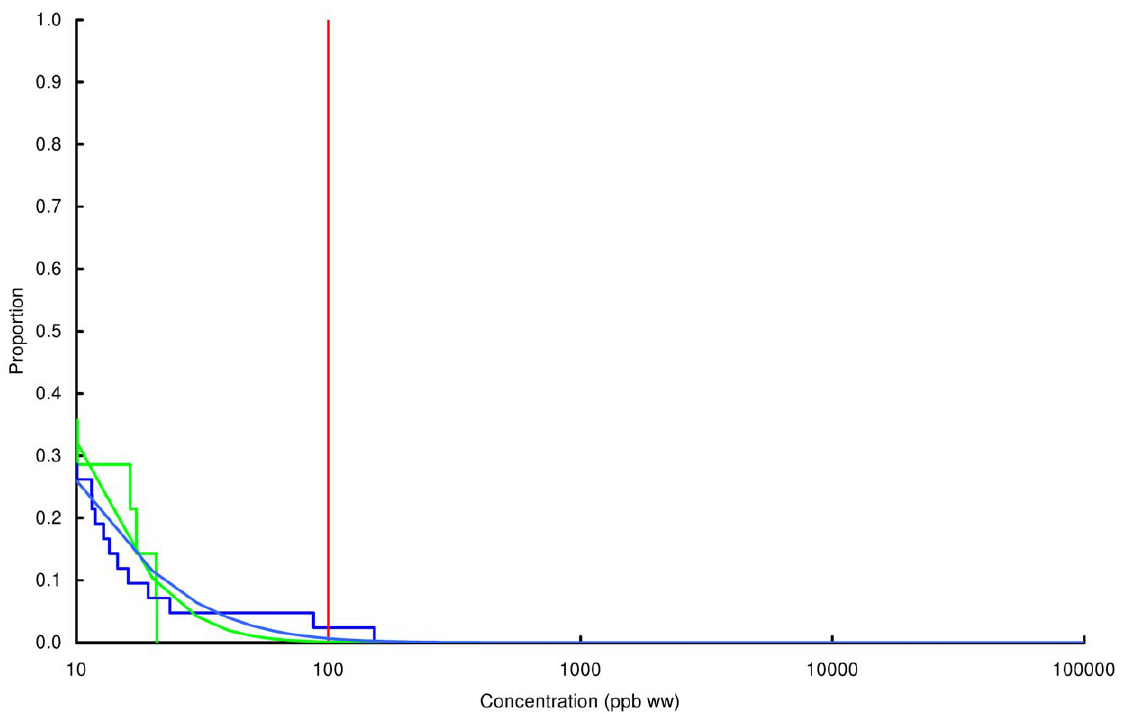
Figure 2. Exceedance distribution of lead concentrations in chicken. Observed (stepped line) and fitted (curve) exceedance distribution of lead concentrations (ppb wet weight) in chicken cooked using acidic (green) and non-acidic (blue) methods. The curves represent lognormal distributions fitted to all the data, including those below the limit of quantification, by a maximum-likelihood method involving left-censoring at the LOD/LOQ. The red vertical line shows the statutory maximum residue level (MRL) for poultry and other non-game meat.